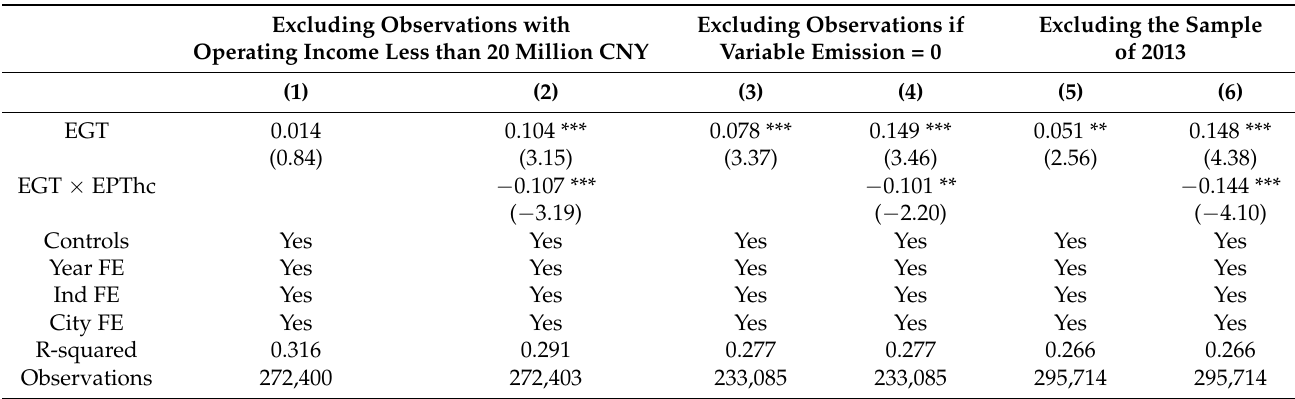
Table 6. Sample selection.